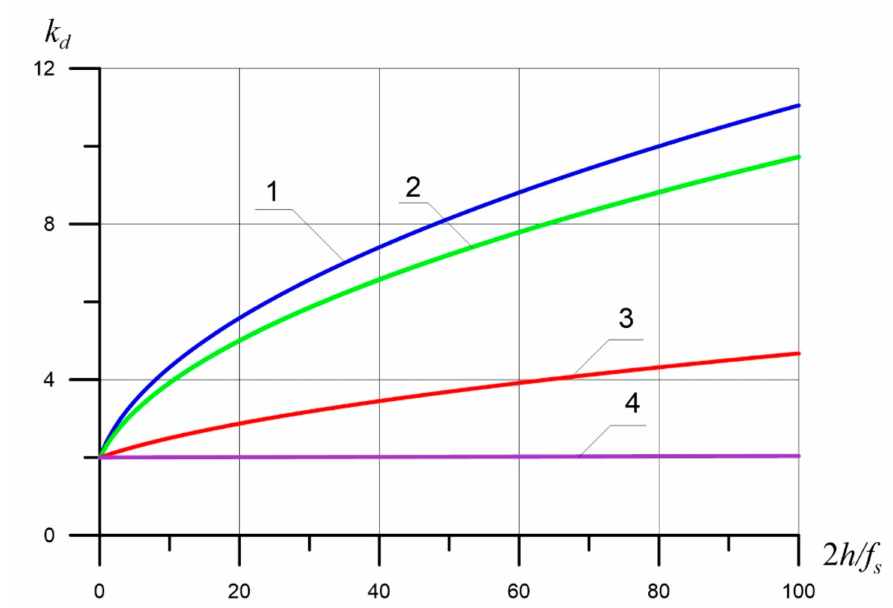
Figure 2. Dependence of the dynamic coe ffi cient k d on the relative height of the beam section 2h / f s at various ratios of the beam mass to the mass of the falling load M B / M A : ( 1 ) M B / M A = 0; ( 2 ) M B / M A =